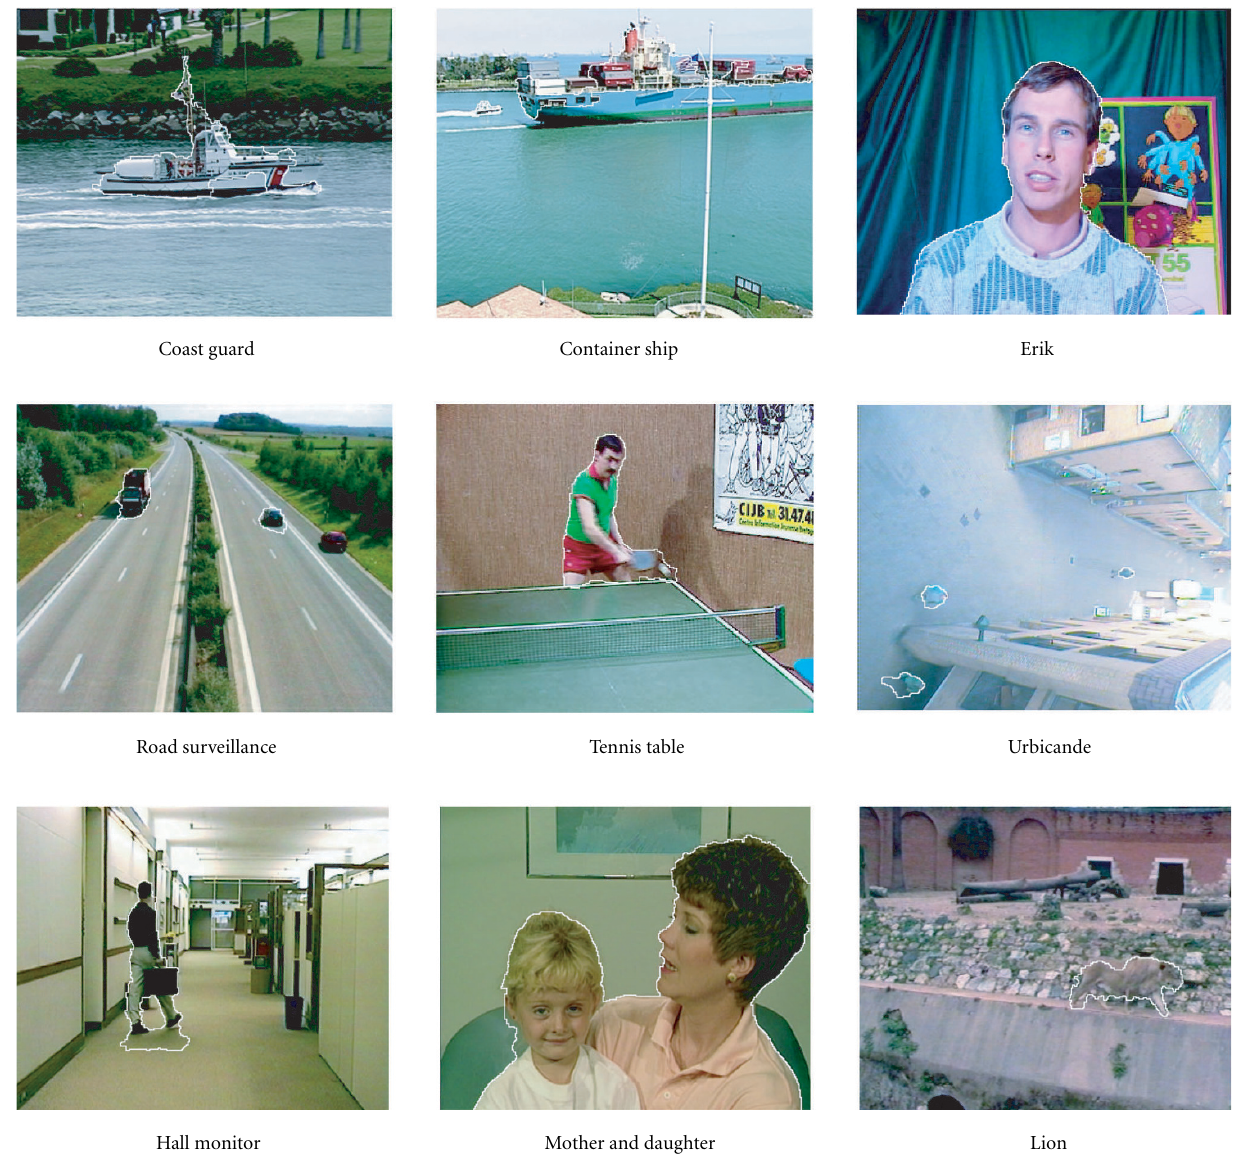
Figure 7: Results of video object